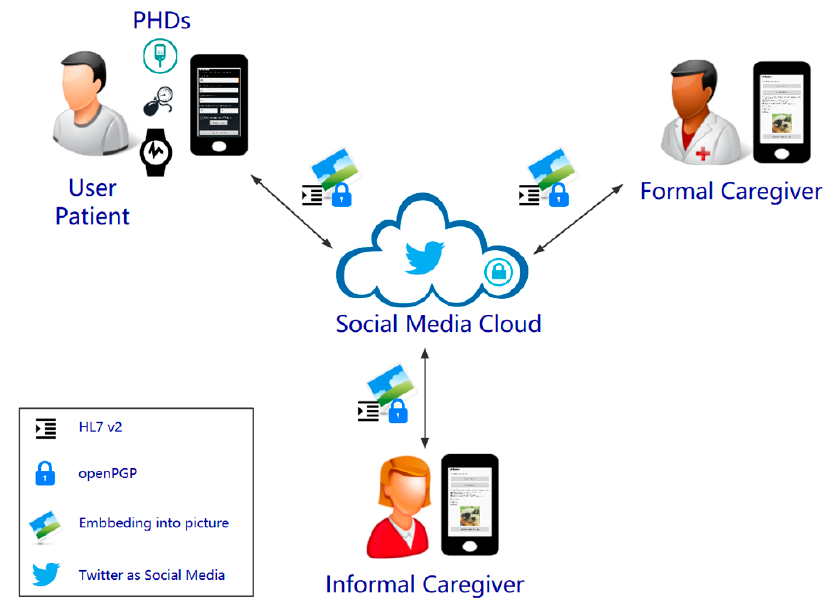
Figure 3. Architecture of the proof of concept using Twitter, Health Level 7 (HL7), open Pretty Good Privacy (openPGP) and a specific embedding algorithm.